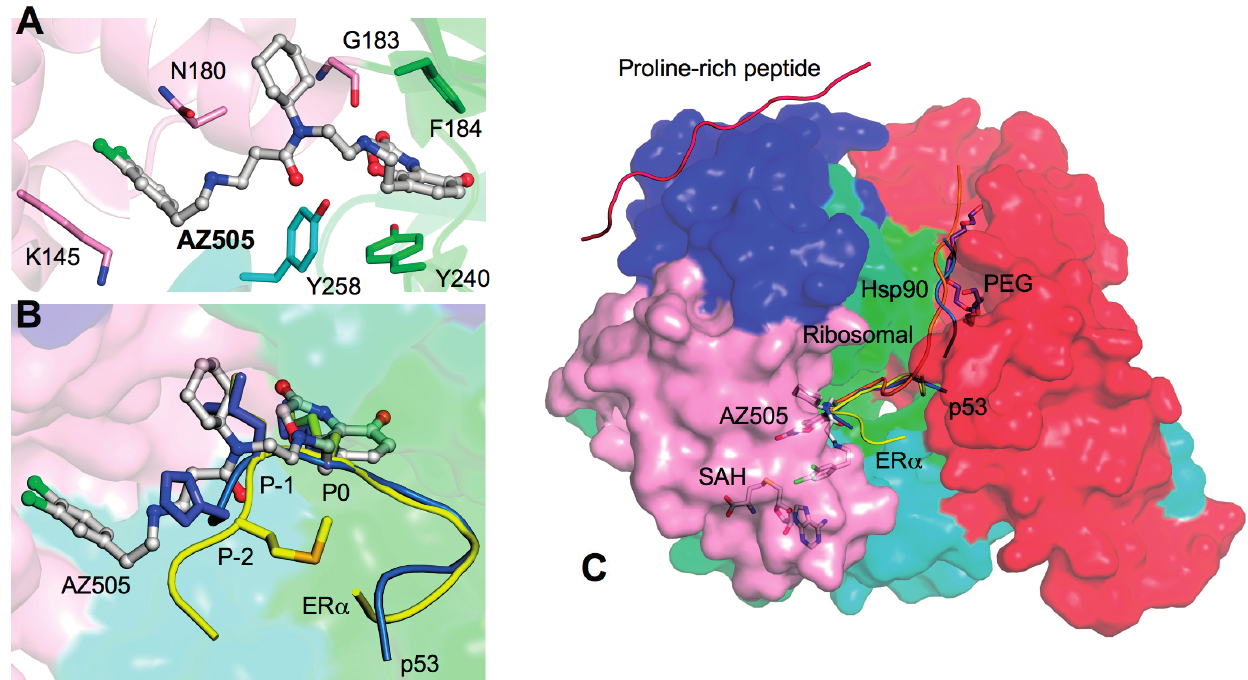
Figure 8. AZ505-bound SMYD2 structure. ( A ) Interactions between AZ505 and SMYD2. AZ505 is depicted by balls-and-sticks with the carbon atoms colored in white. SMYD2 residues are depicted by sticks colored according to domains; ( B ) Comparison of the binding sites of ER α , p53, and AZ505. The ER α and p53 peptides are depicted by sticks and colored in yellow and blue. AZ505 is represented in the same way as in ( A ); and ( C ) Surface representation of SMYD2–ER α structure illustrates potential drug targeting sites: ER α (yellow), p53 (blue), PEG (purple), Hsp90 (light blue), the ribosomal peptide (orange), and proline-rich peptide (hot pink). SAH and AZ505 are depicted by